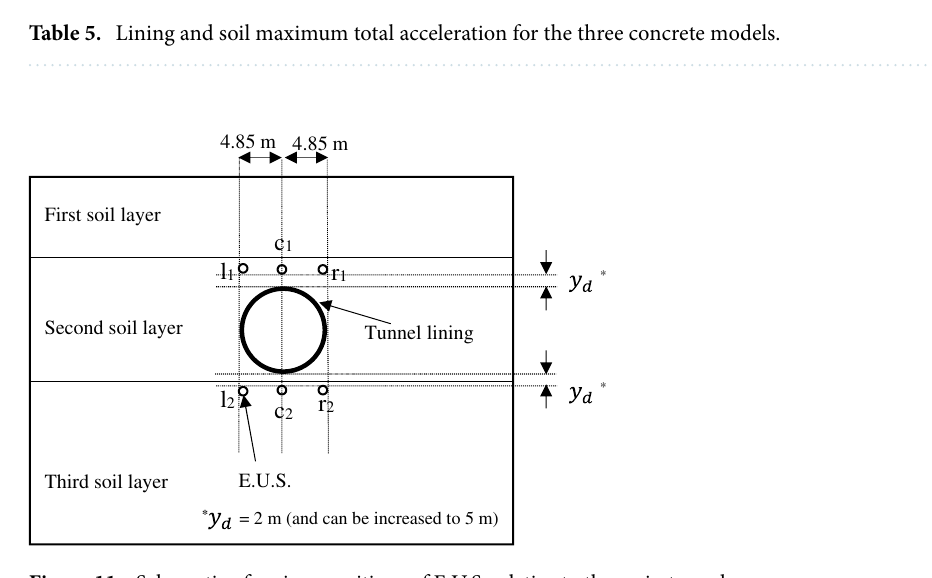
Figure 11. Schematic of various positions of E.U.S. relative to the main